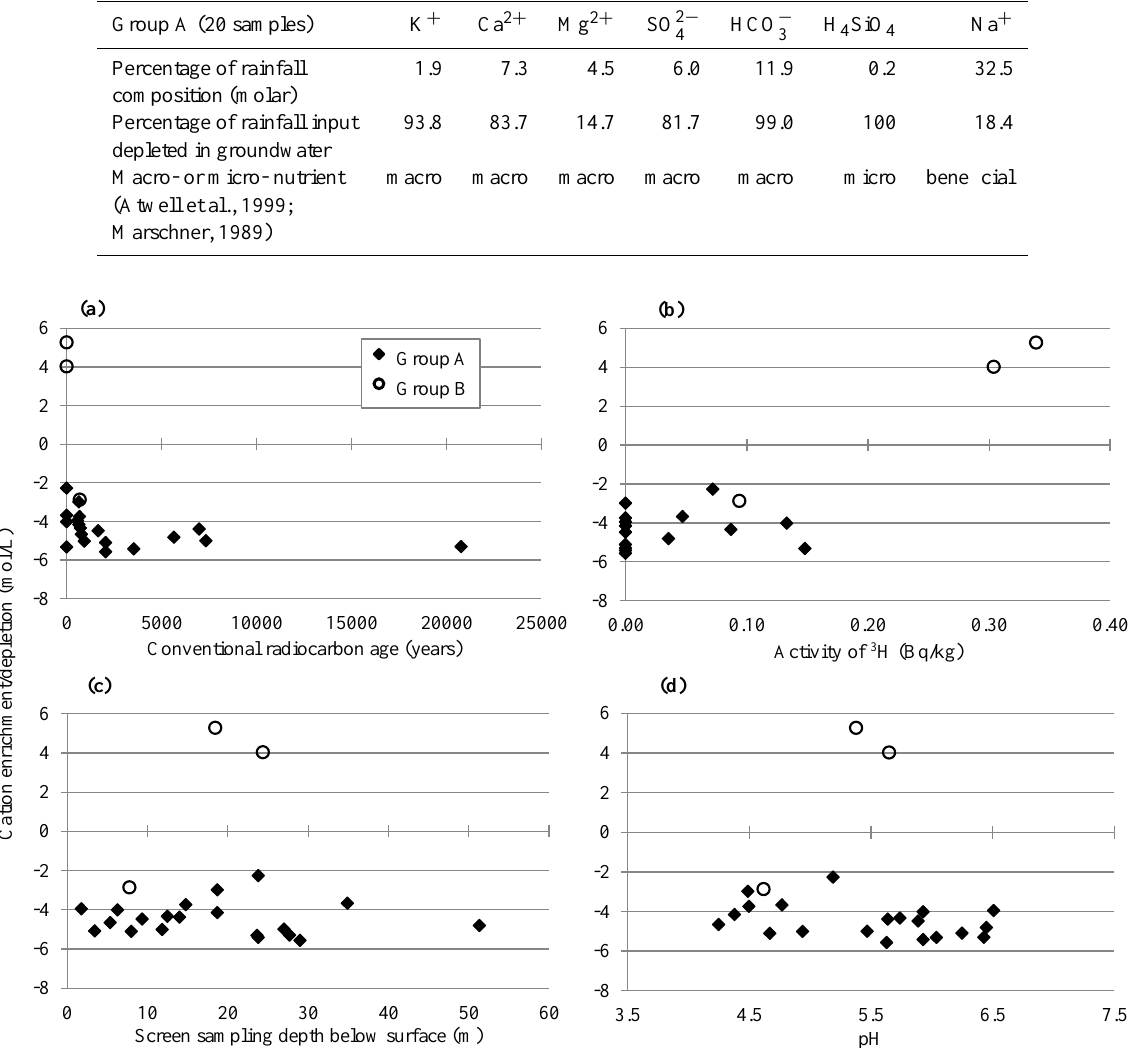
Figure 7. The cation depletion in the groundwater samples (after subtracting rainfall and rock weathering inputs) shows no clear trend with age (a,b), sampling depth (c), or pH (d). The zero values in graphs (a) and (b) indicate values outside the range of the respective dating techniques. A detectable level of tritium indicates that the water is “modern” – recharged in the last ~50 years (Clark and Fritz, 1997; see section 3.1.3). Those samples that contained measurable tritium and also sufficient 14 C to give a radiocarbon date indicate mixing of modern and older groundwater (Table 2).